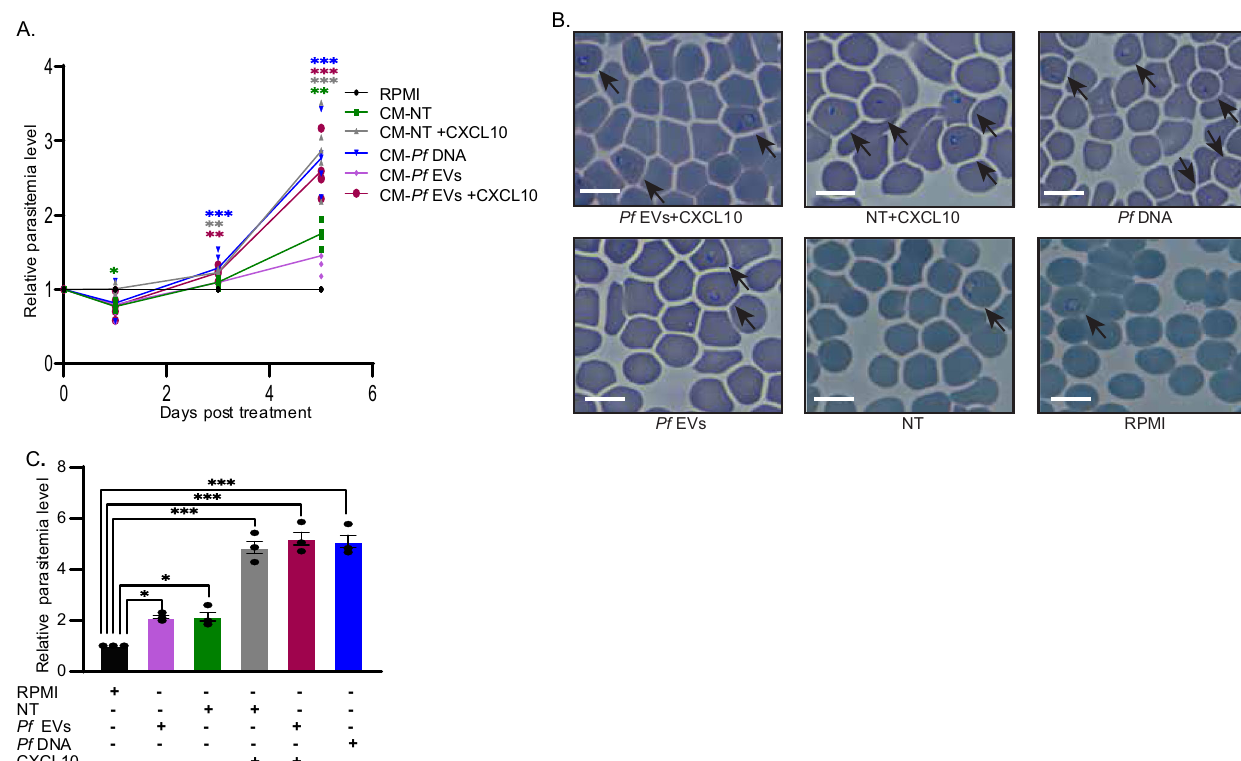
Fig. 5 The chemokine CXCL10 promotes parasite growth. A NF54 Pf parasites were cultured with media containing: (1) complete media [lacking CXCL10] ( Black , RPMI); (2) media harvested from untreated THP-1 cells [lacking CXCL10] ( Green , CM-NT); (3) media harvested from untreated THP-1 cells